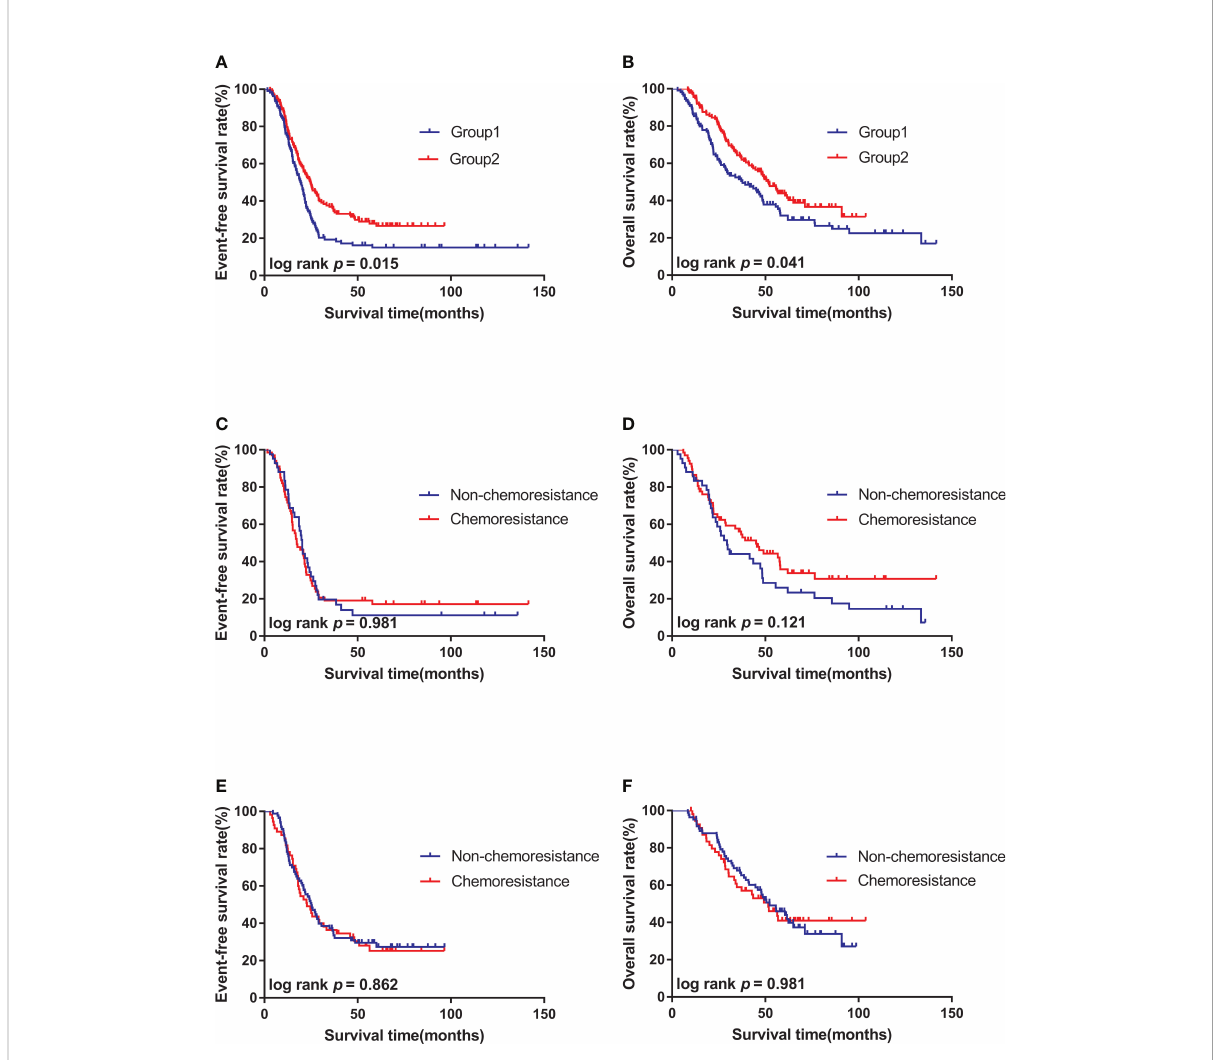
FIGURE 1 Survival curves of high-risk neuroblastoma of different subgroups. (A) . The 3-year EFS of patients in Group 2 (n = 138) was better than that in Group 1 (n = 109). (B) . The 3-year OS of patients in Group 2 (n = 138) was better than that in Group 1(n = 109). (C) . There was no signi fi cant difference in 3-year EFS between chemoresistance (n = 67) and non-chemoresistance (n = 42) patients in Group 1. (D) . There was no signi fi cant difference in 3-year OS between chemoresistance (n = 67) and non-chemoresistance (n = 42) patients in Group 1; (E) . There was no signi fi cant difference in 3-year EFS between chemoresistance (n = 55) and non-chemoresistance (n = 83) patients in Group 2. (F) . There was no signi fi cant difference in 3-year OS between chemoresistance (n = 55) and non-chemoresistance (n = 83) patients in Group